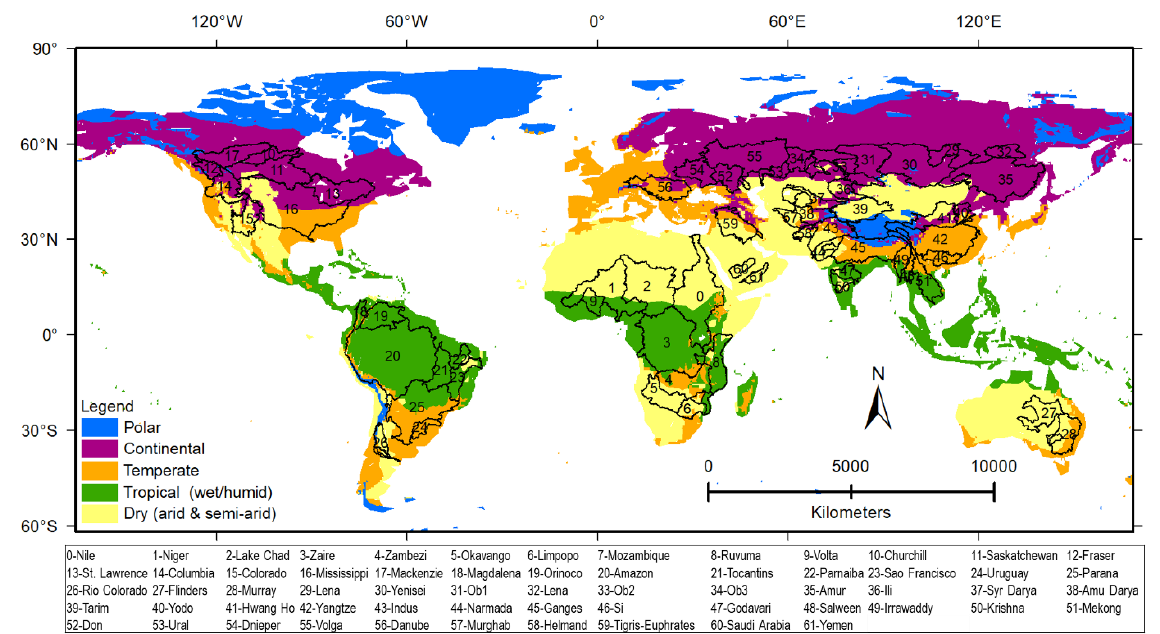
Figure 1. Spatial distribution of the 62 global watersheds (names are shown in the bottom) examined in this study. Also shown are the simplified Köppen – Geiger global climate zones [93].